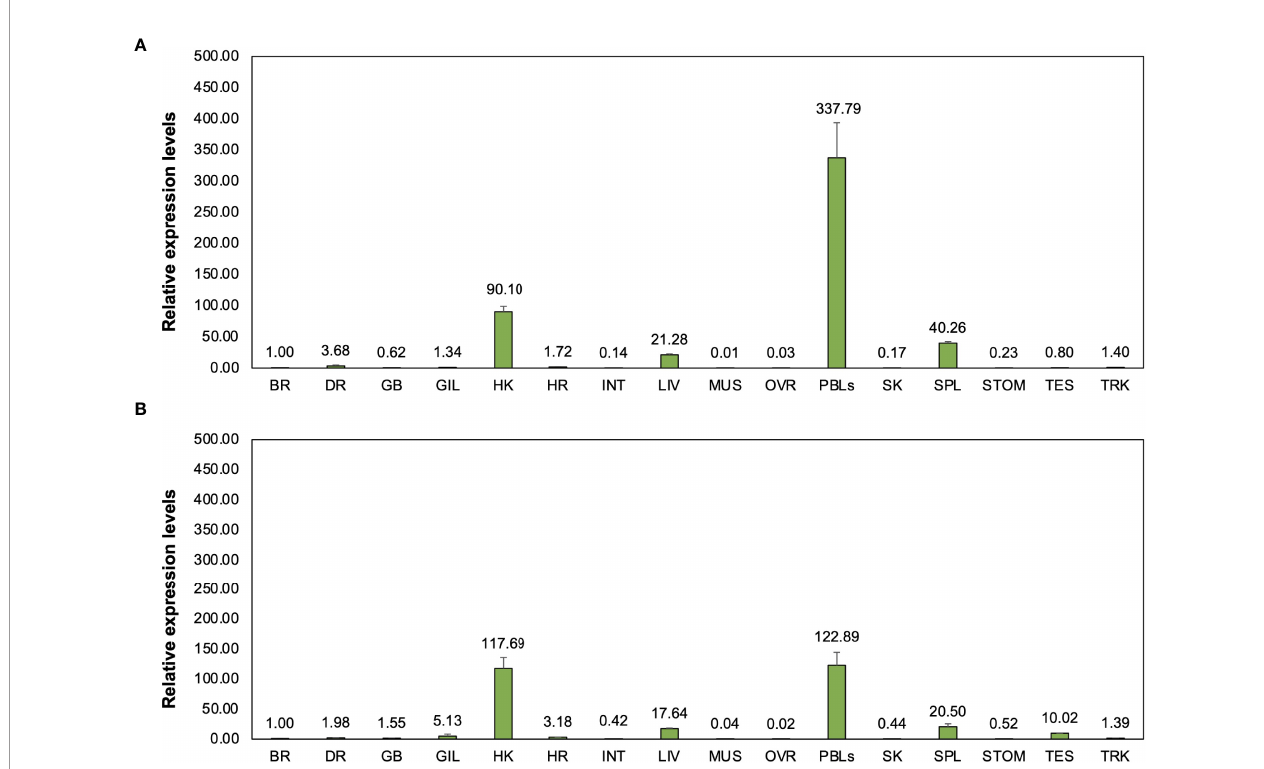
FIGURE 7 | Representation of relative expression levels and distribution of two novel Igh m molecules in bighead cat fi sh including Cm _mIgM2 (A) and Cm _mIgM3 (B) in sixteen tissues. All experiments are done in triplicate